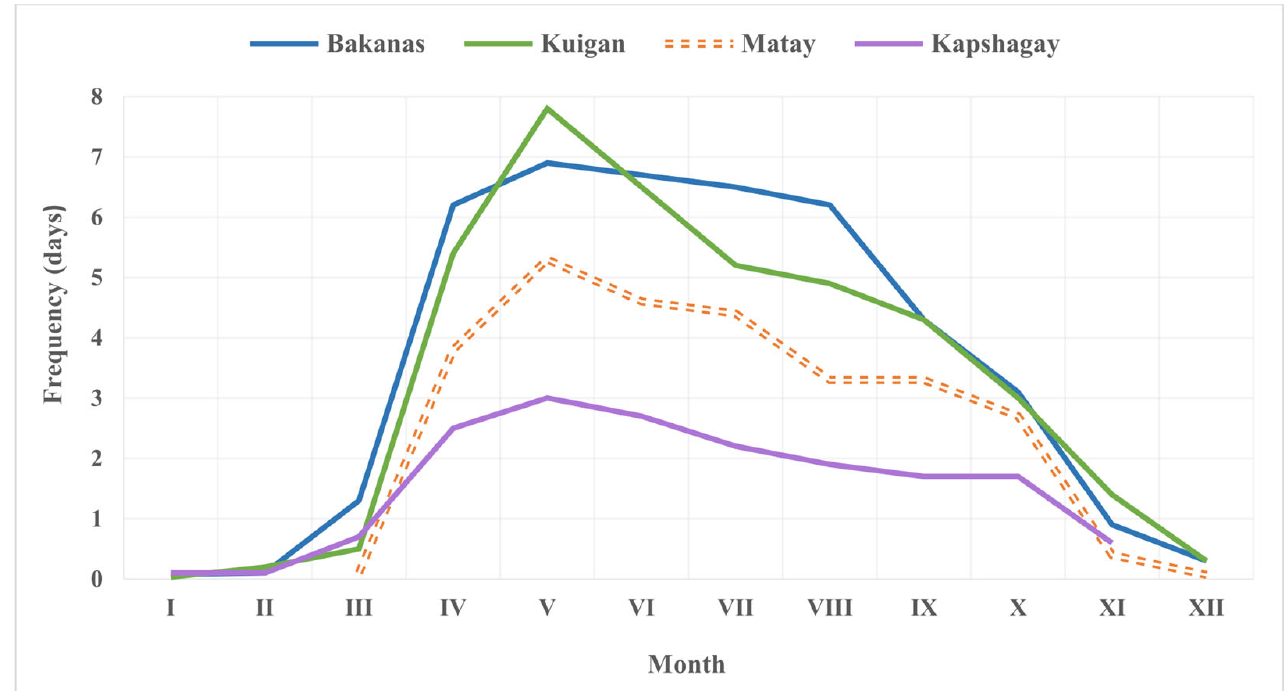
Figure 4. Seasonal frequency of storms for the period 1966–2003 in the Southern Balkash deserts.